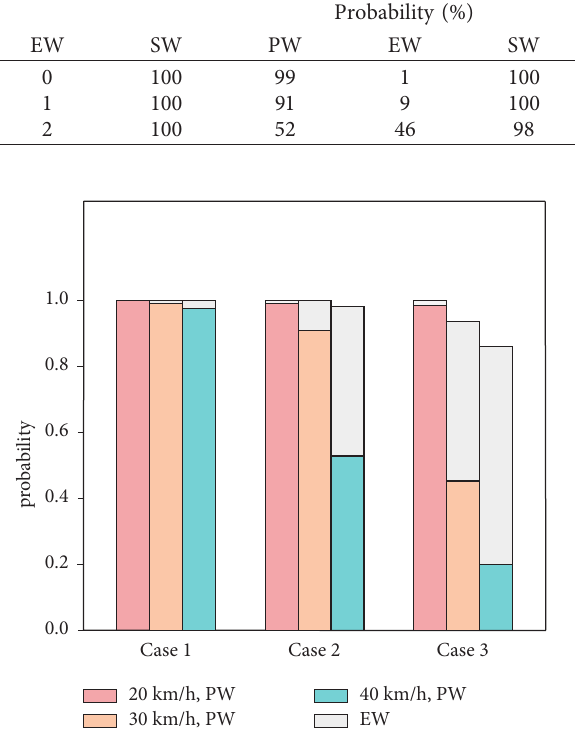
Figure 20: Test results for scenario 1.